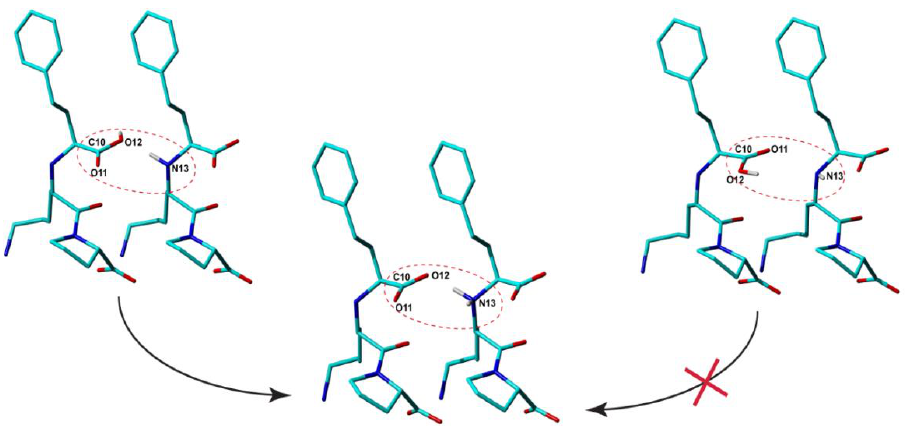
Figure 5. Intermolecular arrangements of Lisinopril molecules, which differ between themselves by the relative conformations of the -C10OOH and -N13H amine moieties: by Density Functional